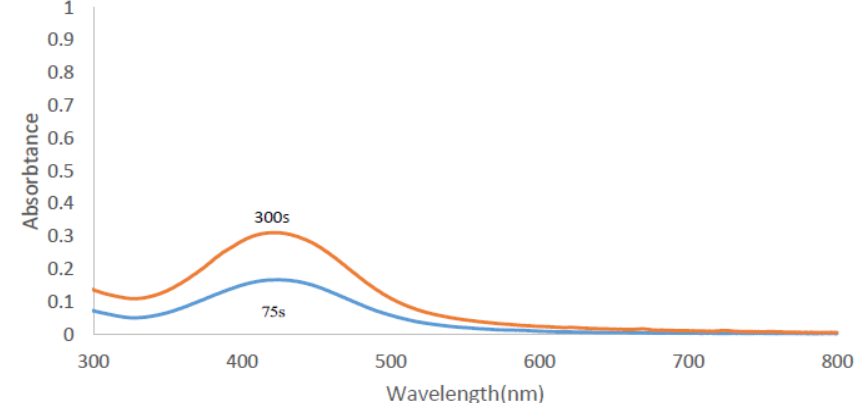
Fig. 2: Absorption spectra of silver-cobalt nanoparticles prepared from silver nanoparticles synthesized at intervals of 75 seconds and 300 seconds (The electrical current adjusted at 1amp and rotational speed was 3000 rpm).